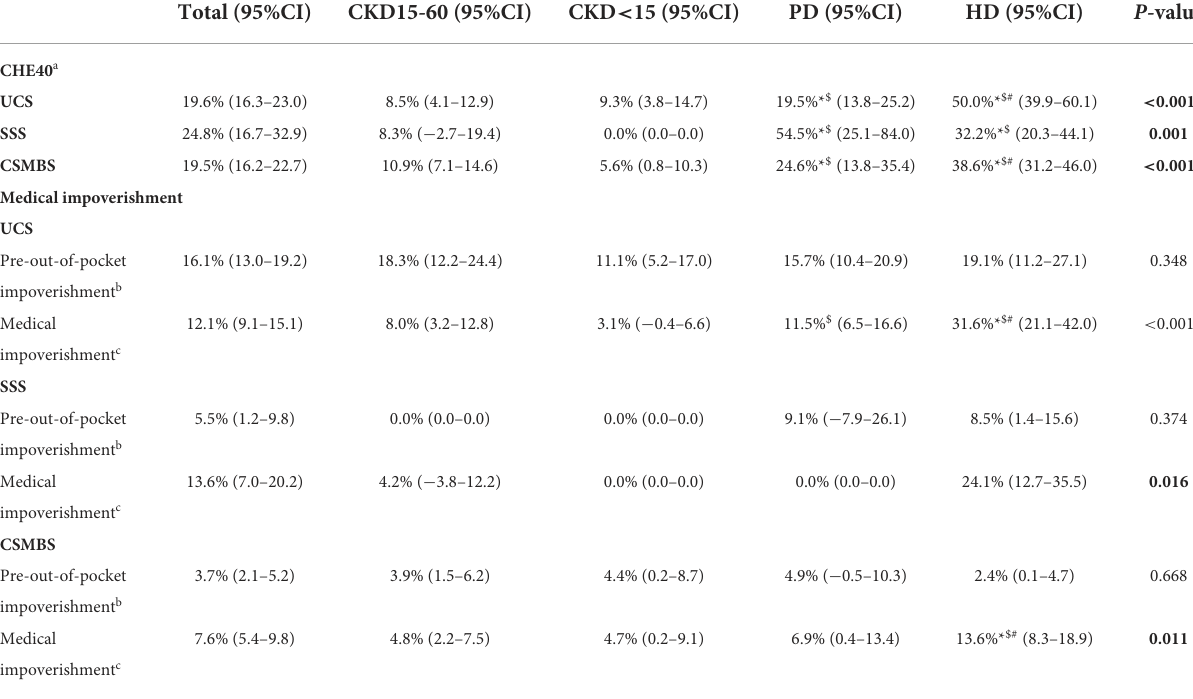
TABLE 2 Proportion of catastrophic health expenditure (CHE40) and impoverishment by CKD